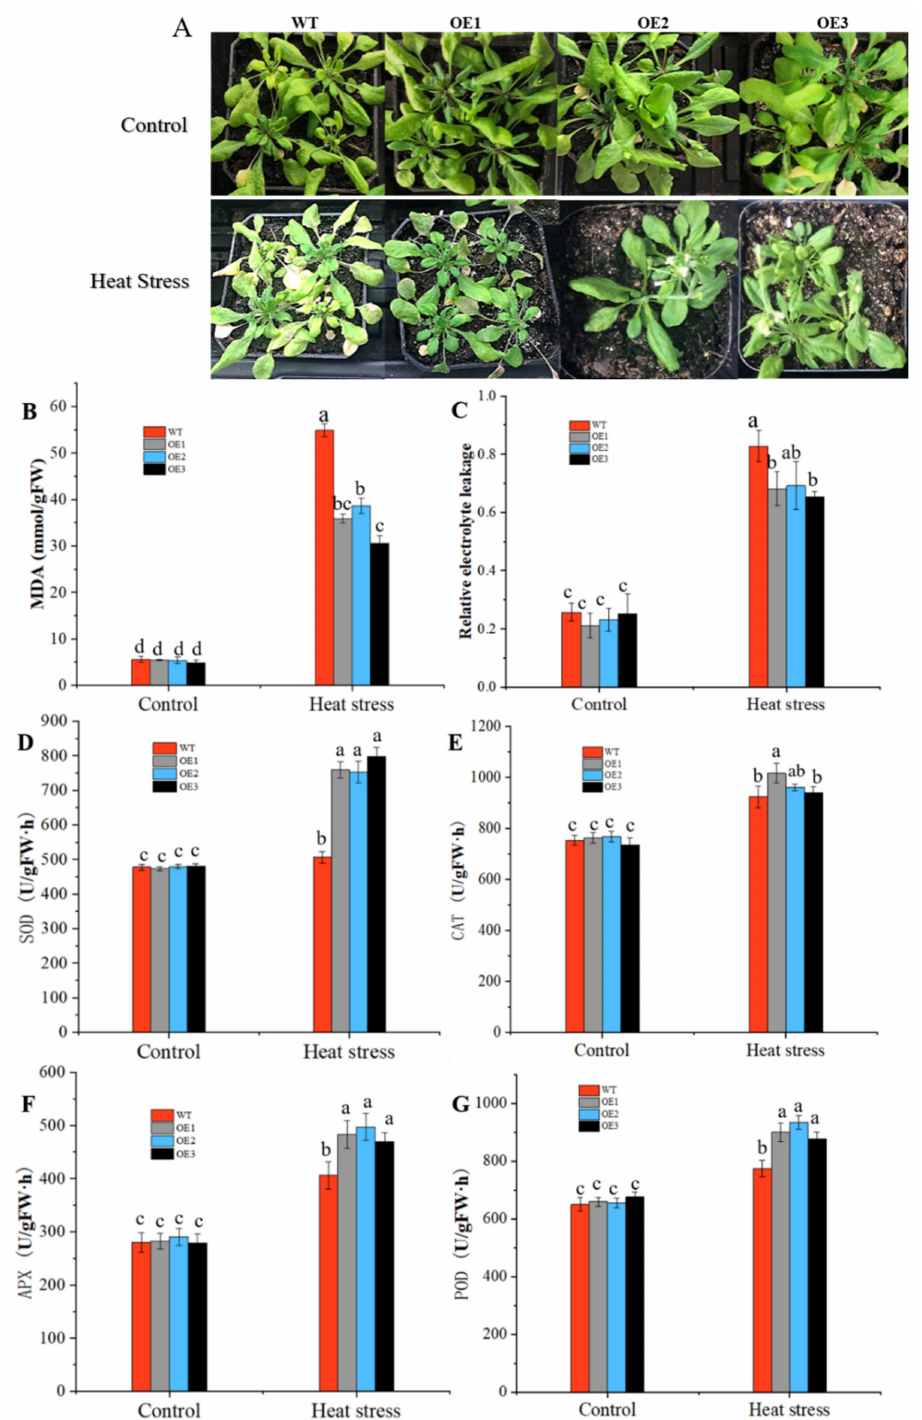
Figure 4. Heat resistance of transgenic CaHSP18.1a -OE Arabidopsis plants. ( A ) Phenotypes of 42 ◦ C-treated wild-type (WT) and transgenic Arabidopsis ; ( B – C ) Malonaldehyde (MDA) and relative electrolyte leakage (REL) of WT and transgenic Arabidopsis ; ( D – G ) Superoxide dismutase (SOD), catalase (CAT), peroxidase (POD), and ascorbic acid peroxidase (APX) activity of WT and transgenic Arabidopsis . Data are means with standard deviations of three biological replicates. Different letters denote statistical significance ( p ≤